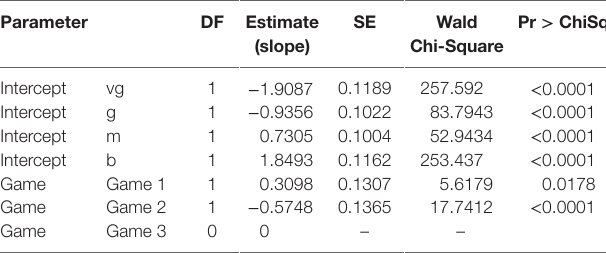
TABLe 12 | Comparisons between OR and HR for approximation of the